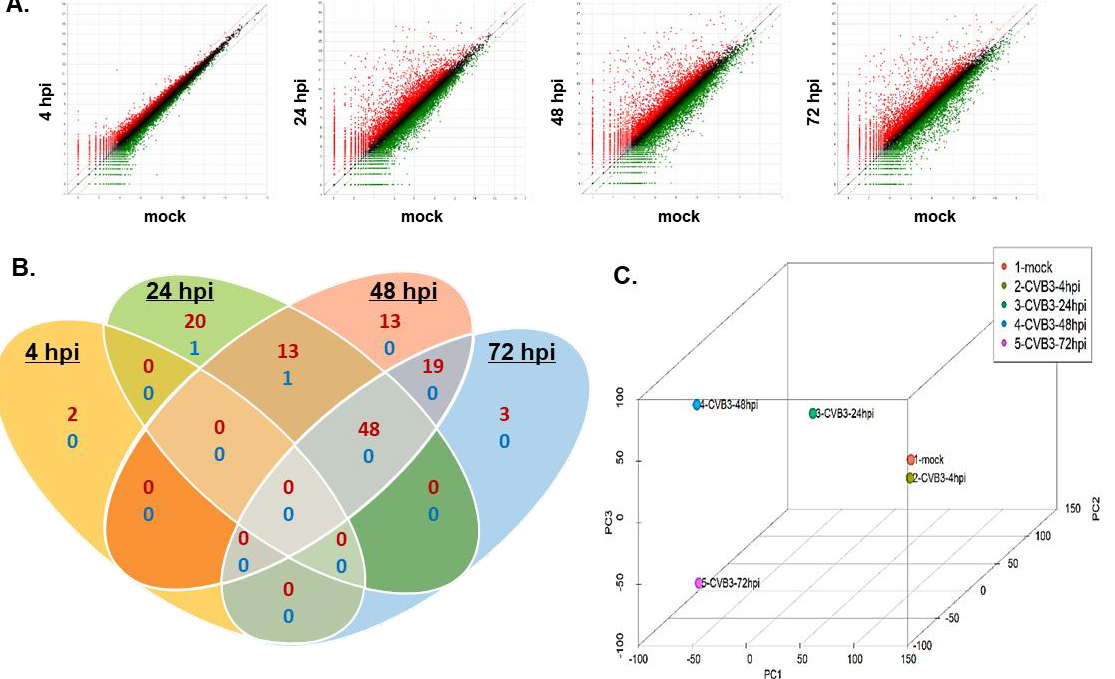
Figure 2. QuantSeq analysis reveals differential expression patterns of host genes in CVB3-infected hNPCs. hNPCs were infected with CVB3 (MOI 5) and RNA was harvested at 4, 24, 48, and 72 h post infection (hpi). ( A ) Scatter plot shows the x-axis and y-axis indicating the expression levels of genes from mock-infected and virus-infected groups, respectively. Relatively highly expressed genes in the virus-infected groups (red) and mock-infected groups (green) are depicted. Black dots represent genes that were not classified as differentially expressed. The differentially expressed gene (DEG) count was identified by comparing mock- and virus-infected groups (fold change > 2) ( B ) Venn diagrams representing the overlap in DEG profiles of CVB3-infected cells. Numbers of upregulated genes (more than 100 folds) are indicated in red and downregulated genes are in blue. ( C ) Three-dimensional multi-dimensional scaling (3D-MDS) plot of QuantSeq datasets shows that 24, 48, and 72 hpi samples are clustered in locations different from the mock or 4 hpi samples.